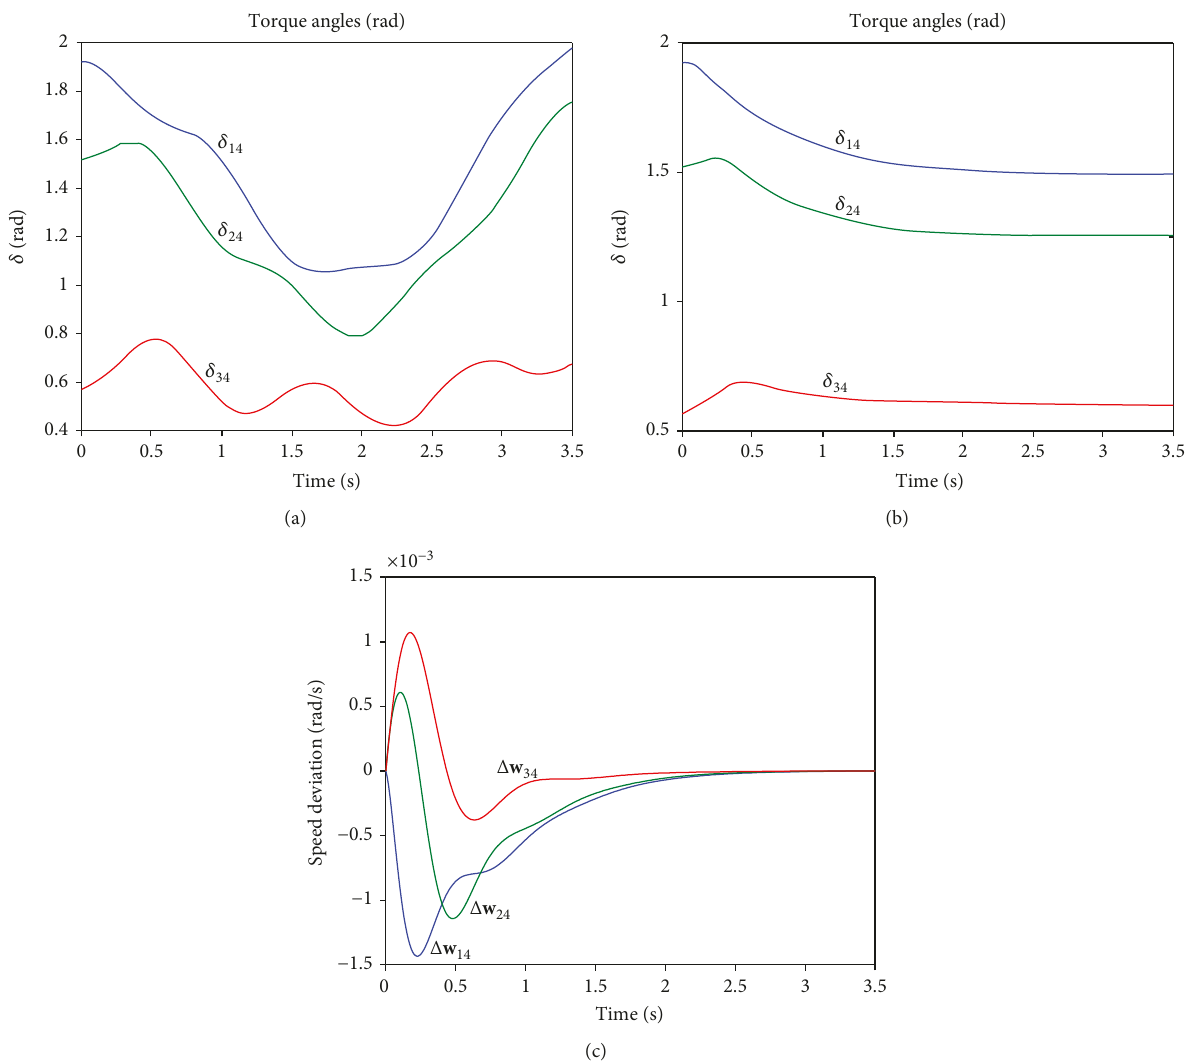
Figure 2: Generators ’ dynamics: (a) rotor angle without controller, (b) rotor angle with the proposed controller, and (c) speed deviation with the proposed